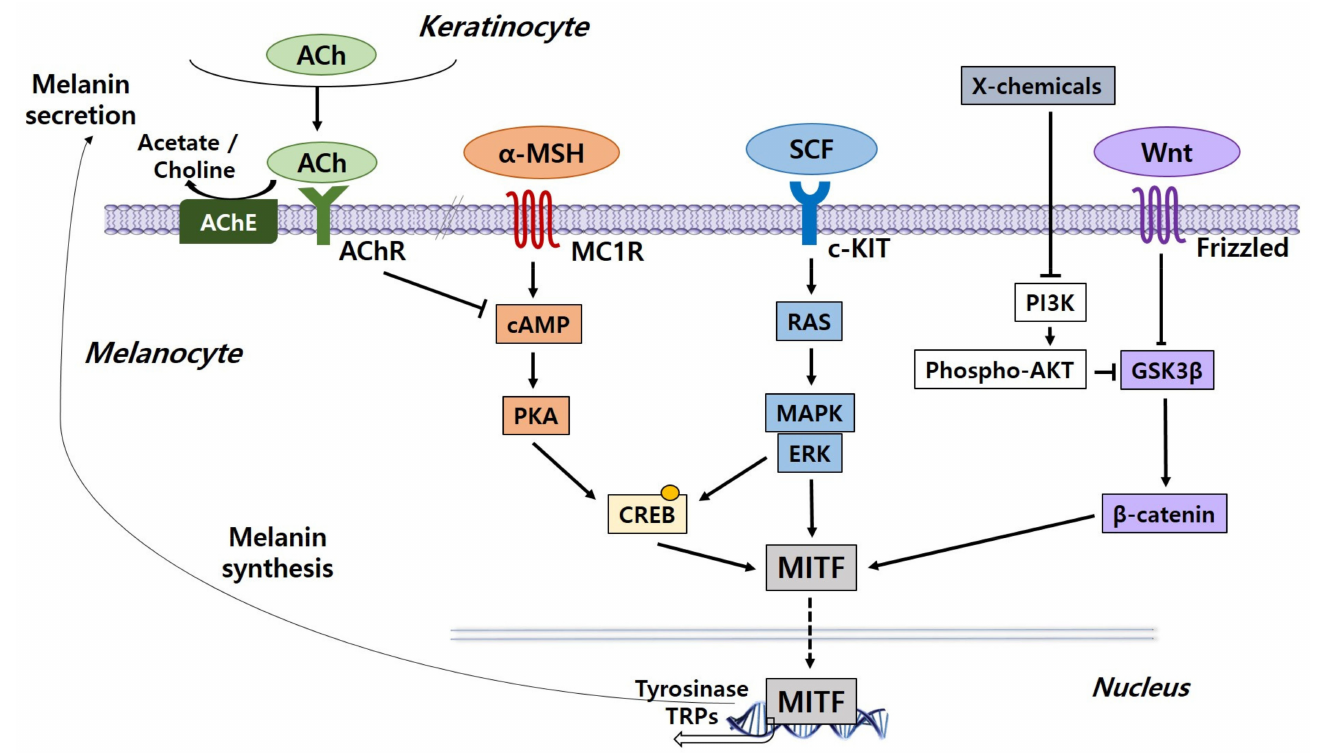
Figure 2. Core signaling pathways associated with the regulation of melanogenesis in melanocytes. Genes encoding specific melanogenic enzymes, including tyrosinase and TRPs, are regulated by the MITF transcription factor, which is consequently regulated by a number of signaling pathways, including α -MSH/MC1R (orange), SCF/KIT (blue) and Wnt/frizzled (purple). Signal transduction is mediated by cAMP/PKA, RAS/MAPK and β catenin pathways. The cholinergic system is a negative regulator of melanogenesis. ACh, acetylcholine; AChE, acetylcholinesterase; AChR, acetylcholine receptor; α -MSH, α -melanocyte-stimulating hormone; cAMP, cyclic adenosine monophosphate; CREB, cAMP response element- binding protein; ERK, extracellular signal-regulated protein kinase; GSK3 β , glycogen synthase kinase 3 β ; c-KIT, tyrosine kinase receptor; MAPK, mitogen-activated protein kinase; MC1R, melanocyte-specific melanocortin 1 receptor; MITF, microphthalmia-associated transcription factor; PKA, protein kinase A; PI3K, phosphatidylinositol 3-kinase; SCF, stem cell factor; TRPs, tyrosinase-related proteins; Wnt, wingless-related integration